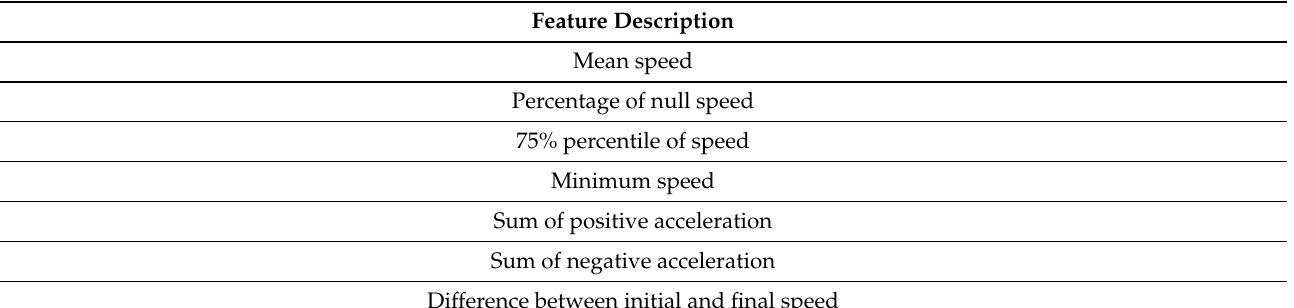
Table 2. Clustering features for the identification of driving